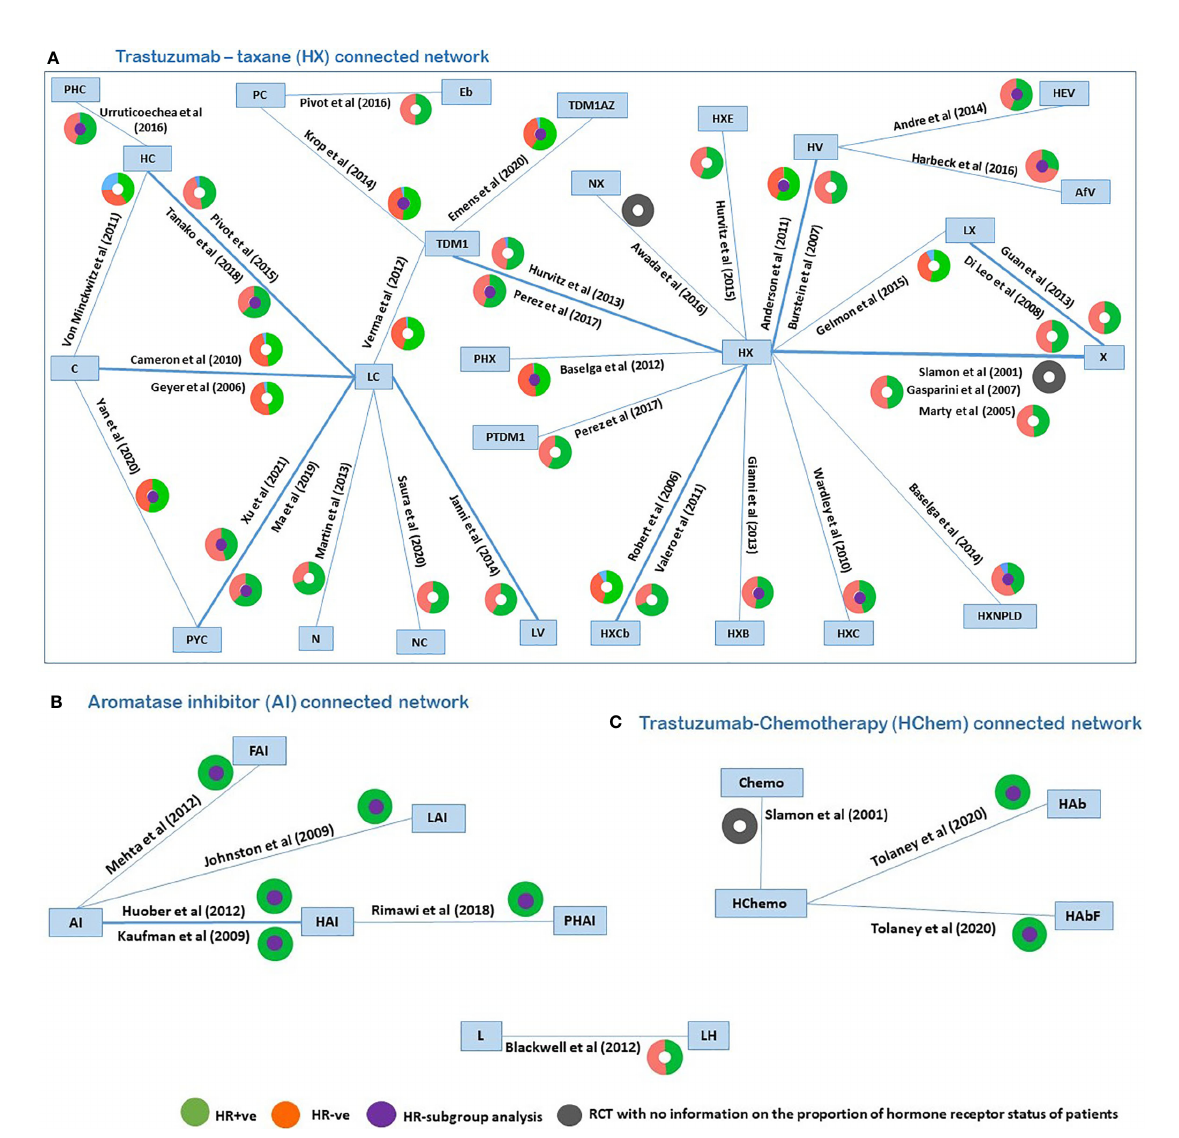
FIGURE 2 Network plots of identi fi ed trials (reporting PFS), with colors in the circles representing the proportion of patients in each RCT that are HR+ve (orange), HR-ve (green), unknown (blue), not reported (grey), and the middle purple circle indicated RCTs reporting subgroup analyses. PHC, pertuzumab + trastuzumab + capecitabine; PC, physician choice; LC, lapatinib + capecitabine; TDM1, trastuzumab emtansine; C, capecitabine; PYC, pyrotinib + capecitabine; LV, lapatinib + vinorelbine; HC, trastuzumab + capecitabine; N, neratinib; TDM1AZ, trastuzumab emtansine + atezolizumab; NX, neratinib + taxane; X, taxane (paclitaxel or docetaxel);NC, neratinib + capecitabine; HX, trastuzumab + taxane; HXB, trastuzumab + taxane + bevacizumab; LX, lapatinib + taxane; HV, trastuzumab + vinorelbine; HXE, trastuzumab + taxane + everolimus; PHX, pertuzumab + trastuzumab + taxane; HXC, trastuzumab + capecitabine + taxane; AfV, afatinib + vinorelbine; HEV, trastuzumab + everolimus + vinorelbine; HXCb, trastuzumab + taxane + carboplatin; PTDM1, pertuzumab + trastuzumab emtansine; Chemo, standard chemotherapy; LH, lapatinib + trastuzumab; L, lapatinib; AI, aromatase inhibitors (letrozole or anastrozole); LAI, lapatinib + AI; FAI, fulverstrant + AI; HAI, trastuzumab +AI; PHAI, pertuzumab + trastuzumab +AI; HAb, trastuzumab + abemaciclib; HAbF, trastuzumab + abemaciclib + fulverstrant; HXNPLD, trastuzumab + taxane + NPLD; NPLD, non-pegylated liposomal doxorubicin; HChemo, trastuzumab + chemotherapy; Eb,